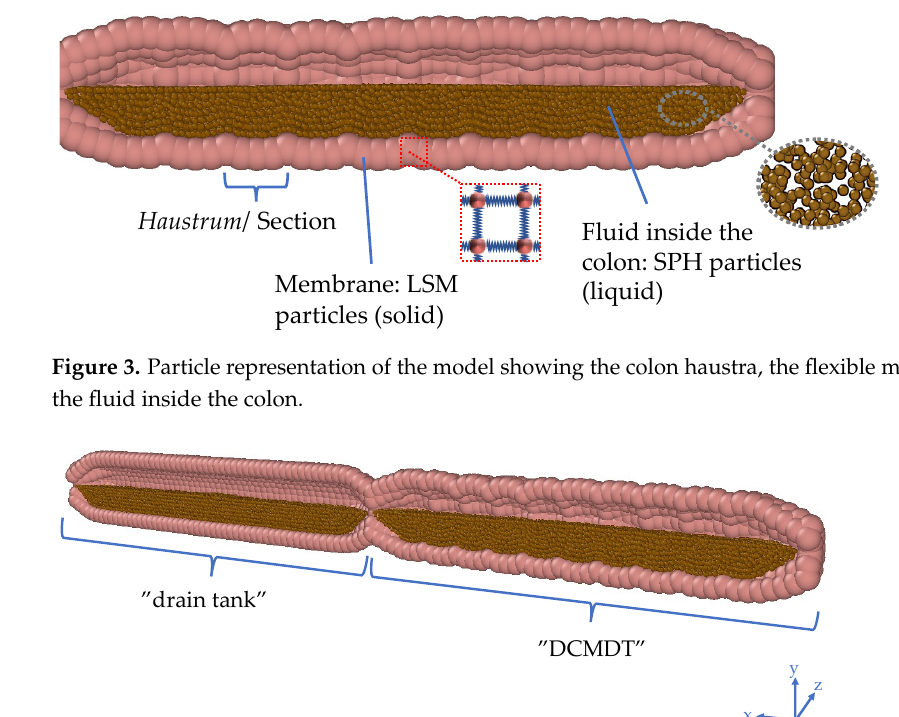
Figure 3. Particle representation of the model showing the colon haustra, the flexible membrane, and the fluid inside the colon.